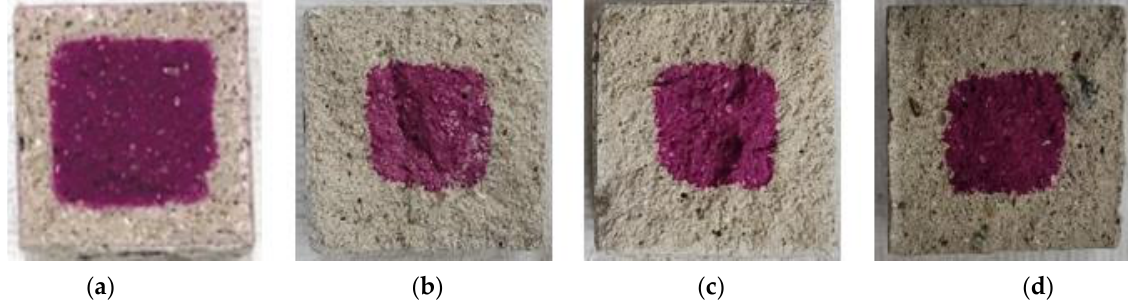
Figure 13. Accelerated carbonation test result of ABFS50: ( a ) 1, ( b ) 2, ( c ) 3, and ( d ) 4 weeks.